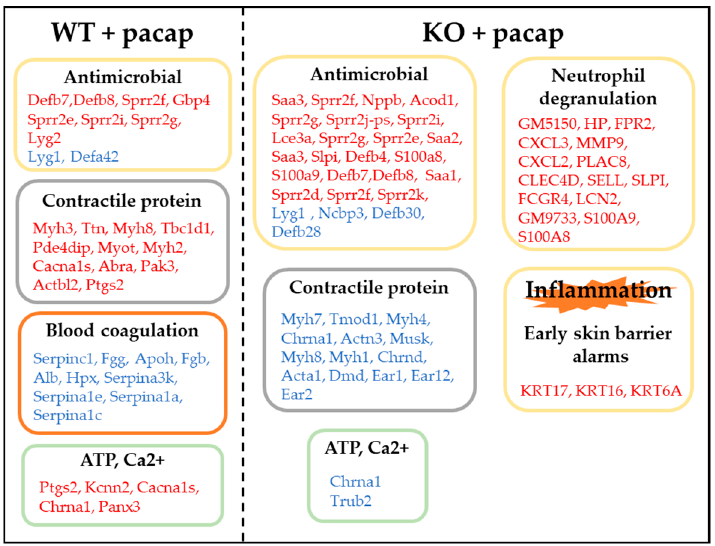
Figure 6. Summary of the genes that may be involved in PACAP-induced membrane translocation of AQP5. Red, up-regulated genes; and blue, down-regulated genes. The gene expression data are publicly available under the GEO series accession number GSE223124 (https://www.ncbi.nlm.nih.gov/geo/query/acc.cgi?acc=GSE223124; accessed on 19 February 2023).